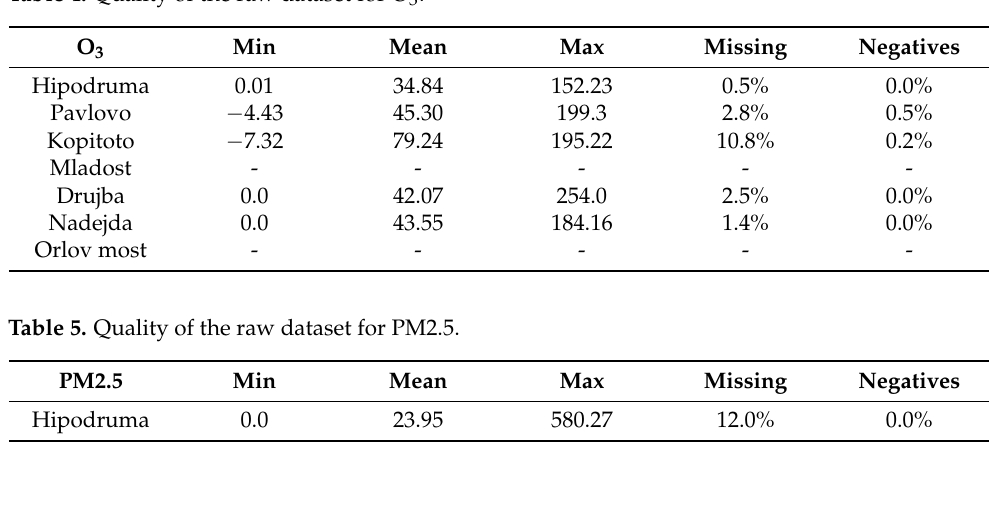
Table 4. Quality of the raw dataset for O 3 .